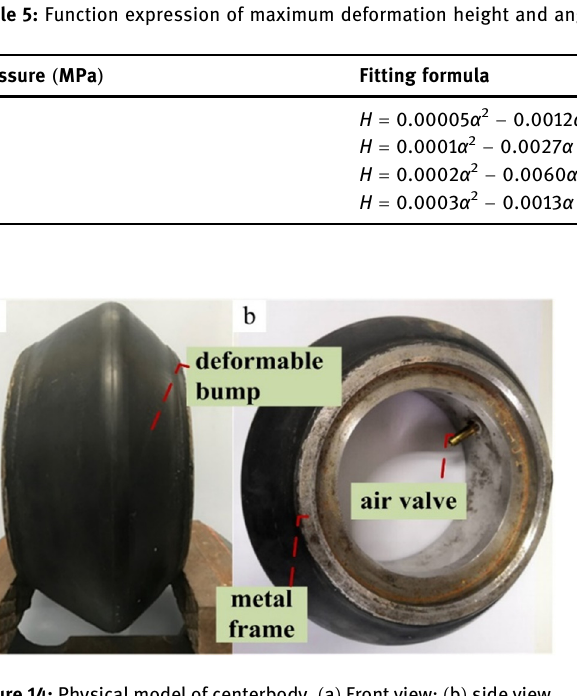
Figure 14: Physical model of centerbody. ( a ) Front view; ( b ) side view.